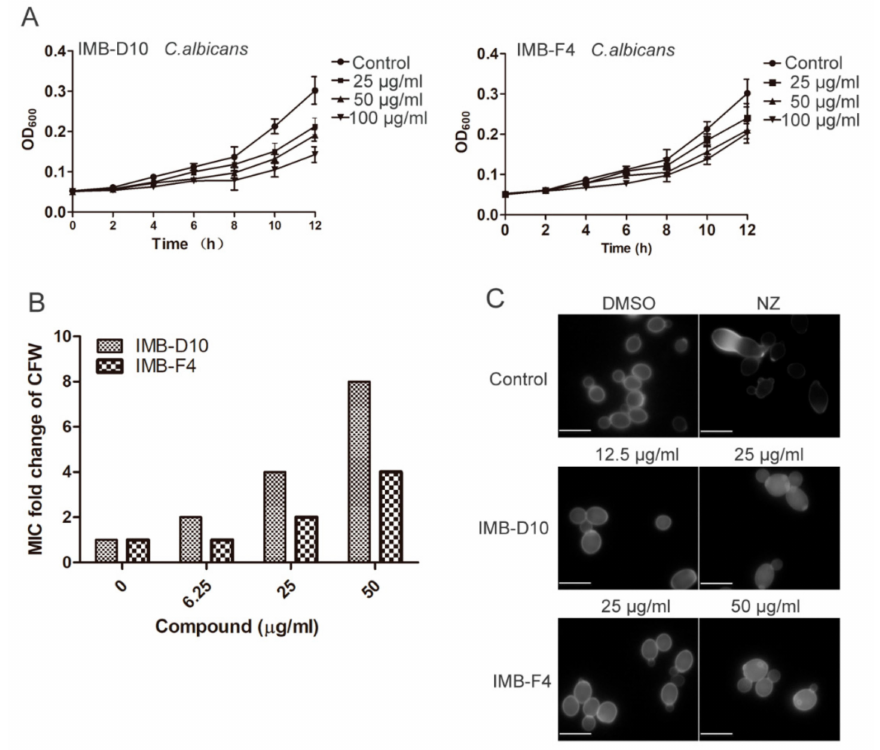
Figure 6. Dose-dependent inhibition of cell growth and chitin synthesis in C. albicans by compounds IMB-D10 and IMB-F4. ( A ) IMB-D10 and IMB-F4 inhibit the growth of C. albicans in a dose-dependent manner. Data are presented as mean ± SD. ( B ) The MICs of CFW to C. albicans in the presence of IMB-D10 or IMB-F4 were determined using checkerboard assay. The fold change of MICs of CFW is shown. ( C ) WT cells were treated with IMB-D10 (12.5 µ g / mL) or IMB-F4 (25 µ g / mL) for 5 hours and then stained with CFW. An equal volume of DMSO (0.25%) or 100 µ g / mL nikkomycin Z (NZ) were